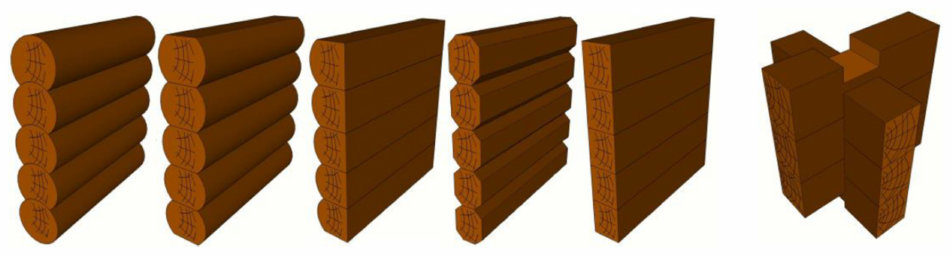
Figure 19. Method of making wooden beam